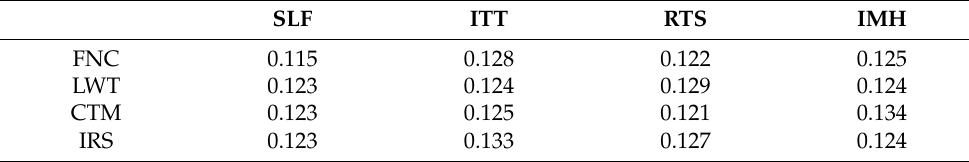
Table A17. Weighted